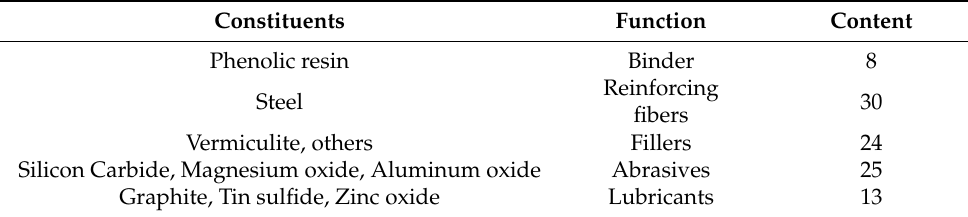
Table 2. Selected constituents of the commercial formulation with their corresponding function (in wt.%) [23].